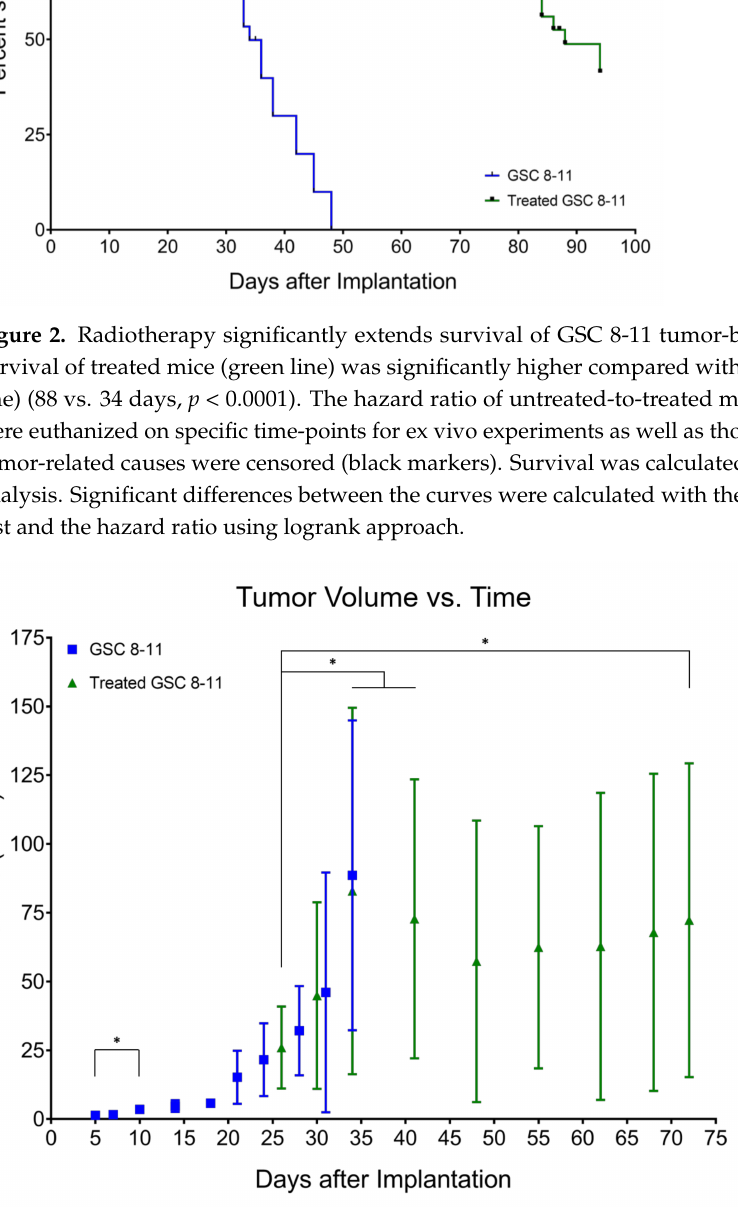
Figure 3. Tumor volume increases during development but does not significantly change through- out regression or recurrence. Average tumor volume, measured from anatomic MRI, is plotted as a function of time in untreated (blue squares) and treated (green triangles) mice. Error bars represent standard deviation (not visible before Day 21 due to scale of Y -axis). These values were log-transformed to correct for heteroscedasticity and tested for significant differences using ordinary one-way ANOVA and follow-up Fisher’s Least Significant Differences tests. Comparisons that produced p < 0.05 were deemed significant. * p <